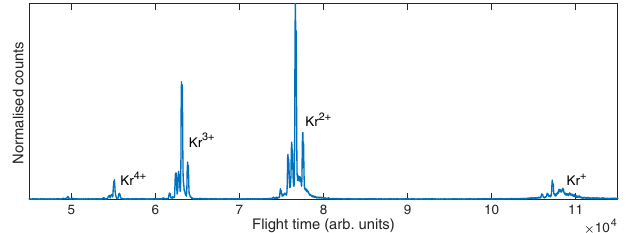
FIG. 6. Time-of-flight spectrum measured in krypton ionized by the soft-x-ray continuum. The presence of Kr 2 þ , Kr 3 þ , and Kr 4 þ clearly indicates the occurrence of Auger relaxation mechanism after the initial photoionization. The isotope structure of Kr is also visible.